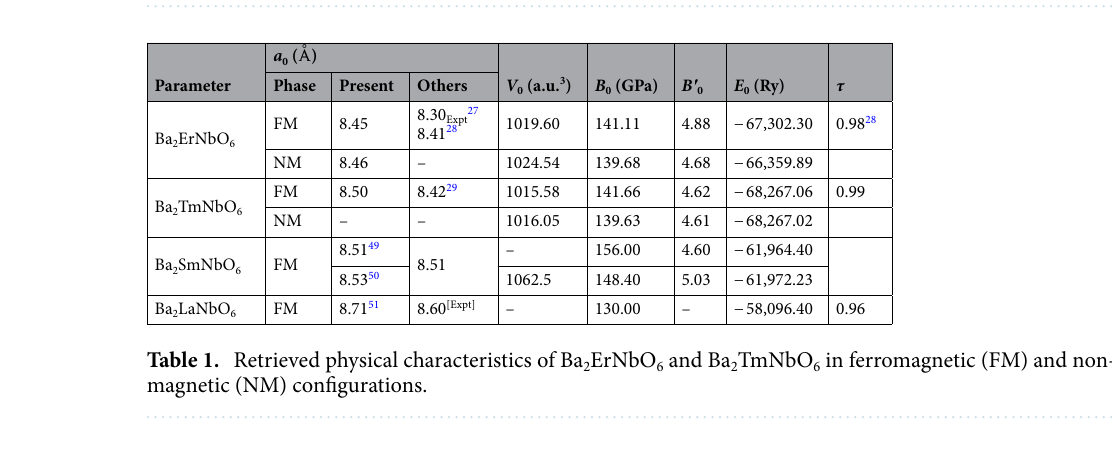
Figure 2. (a, b) DFT structural relaxation of ( a ) Ba 2 ErNbO 6 and ( b ) Ba 2 TmNbO 6 in spin-polarised (FM) and non-spin polarised (NM) configurations.